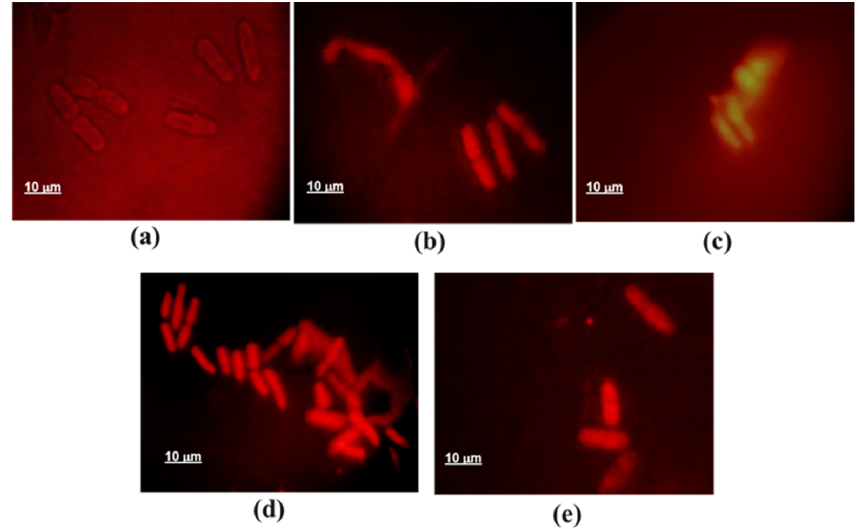
Figure 5. Effect of clove fraction on mitochondrial activity of S. pombe : ( a ) negative control (3% glu- cose of YES medium, 0 μ g·mL − 1 of fraction), ( b ) positive control (0.3% glucose of YES medium, 0 μ g·mL − 1 of fraction), ( c ) Ascorbic acid 0.1 μ g·mL − 1 , ( d ) FEB 8 μ g·mL − 1 , ( e ) FEL 10 μ g·mL − 1 . FEB: clove bud ethanol fraction and FEL: clove leaf ethanol fraction.